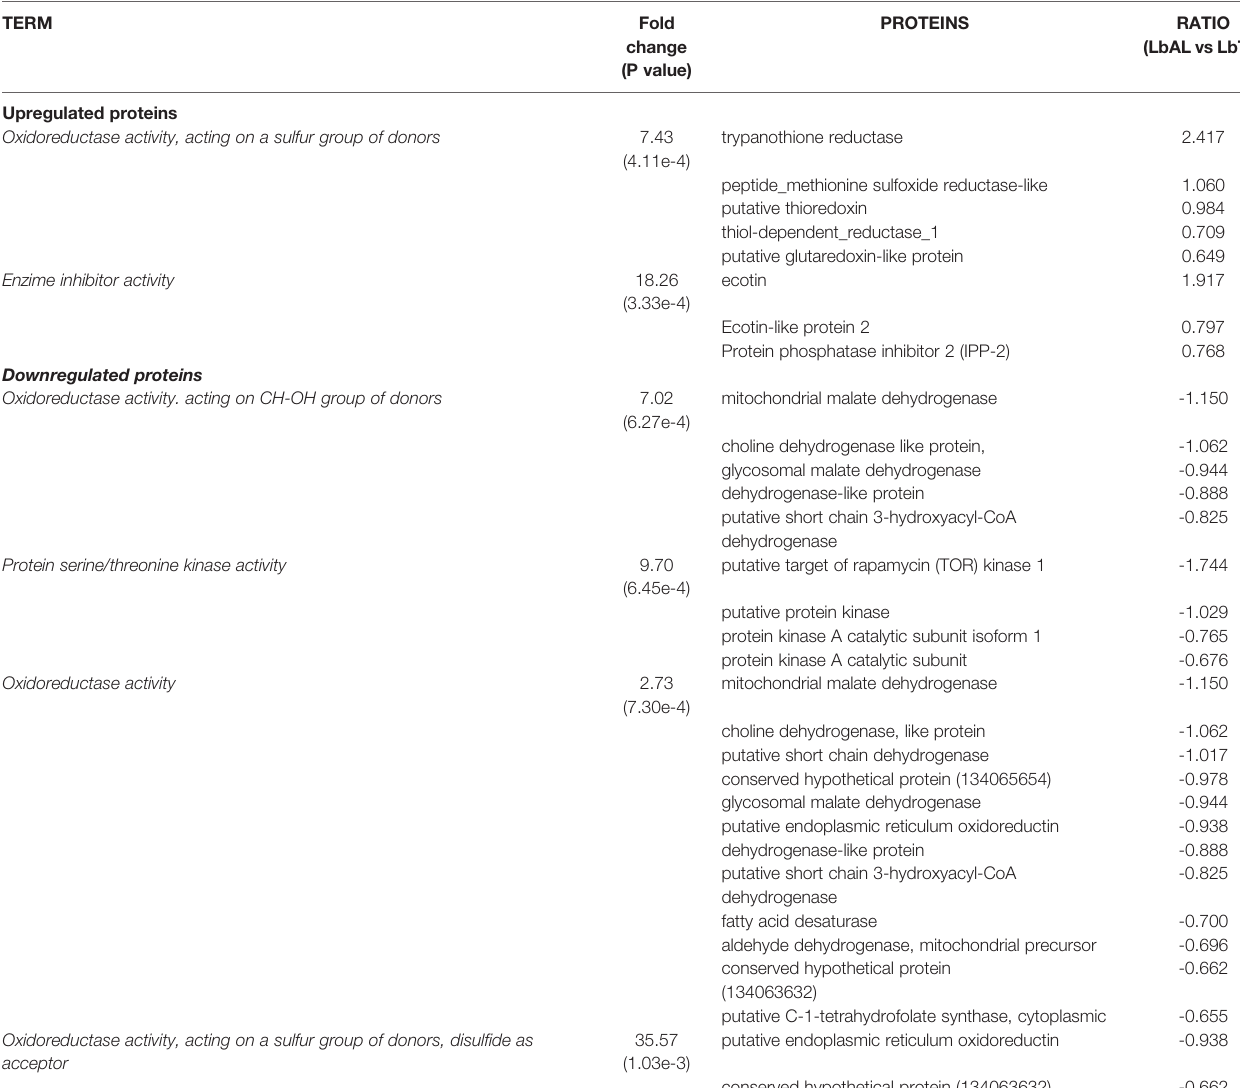
TABLE 1 | Gene Ontology (GO) enrichment analysis of Molecular Function in differentially regulated proteins in L. braziliensis from atypical lesion (LbAL) compared to L. braziliensis from typical lesion (LbTL).